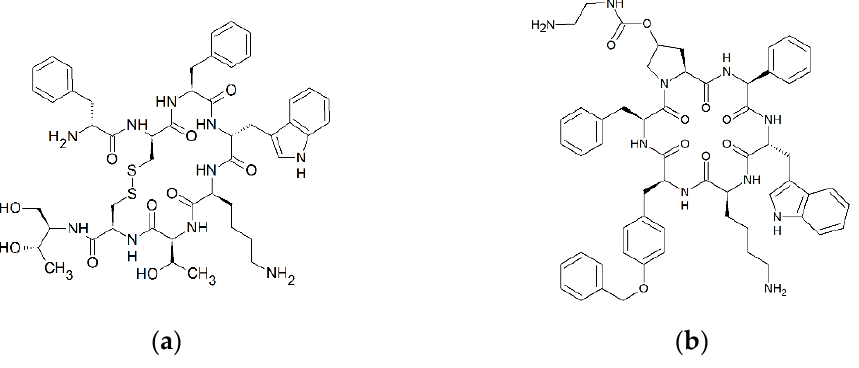
Figure 1. Cyclic structure of octreotide (D-Phe-cyclo[Cys-Phe-D-Trp-Lys-Thr-Cys]-Thr; C 49 H 66 N 10 O 10 S 2 ) ( a ) and pasireotide (cyclo[Hyp(N-(2-aminoethyl)carbamate)-Phg-D-Trp-Lys- Tyr(Bn)-Phe ; C 58 H 66 N 10 O 9 ) ( b ). Formulas were drawn with ChemSketch 2020.1.2. (ACD/Labs, Toronto, ON, Canada).